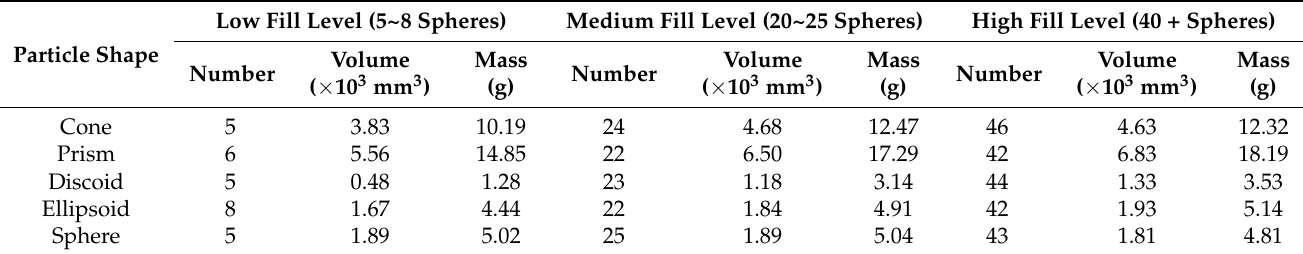
Table 2. Model parameters for different fill